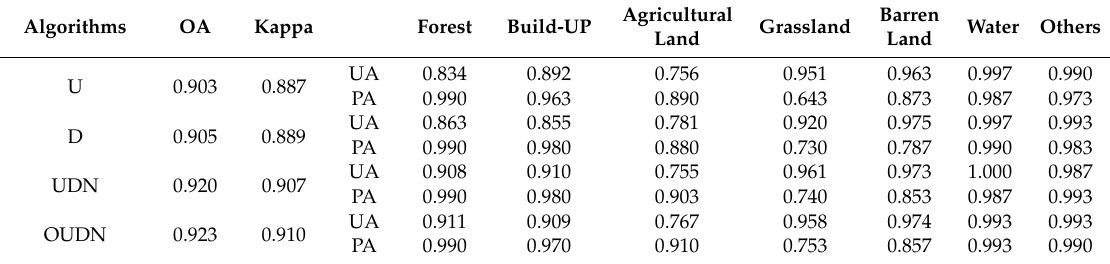
Table 4. The classification accuracies of the U, D, UDN, and OUDN algorithms based on the Spe, including the accuracies (user accuracy (UA) and producer accuracy (PA)) of every class, overall accuracy (OA) and kappa coe ffi cient